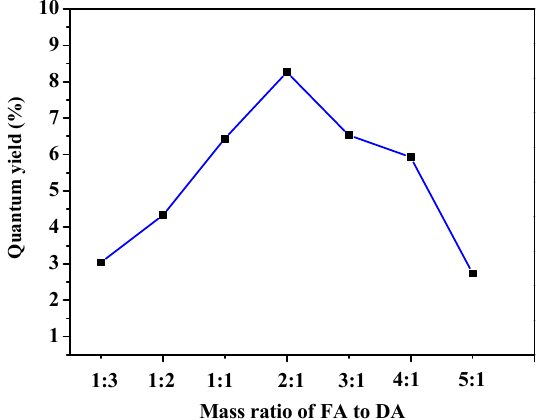
Figure 1. The QYs of the prepared FA-PDA FONs samples.